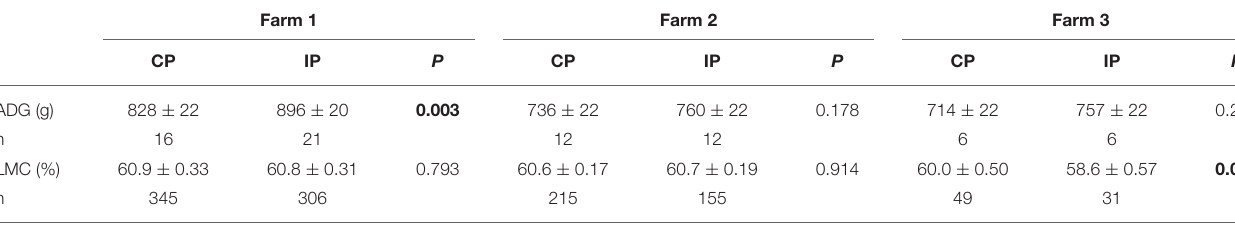
TABLE 10 | Performance data for control (CP) and improved (IP)